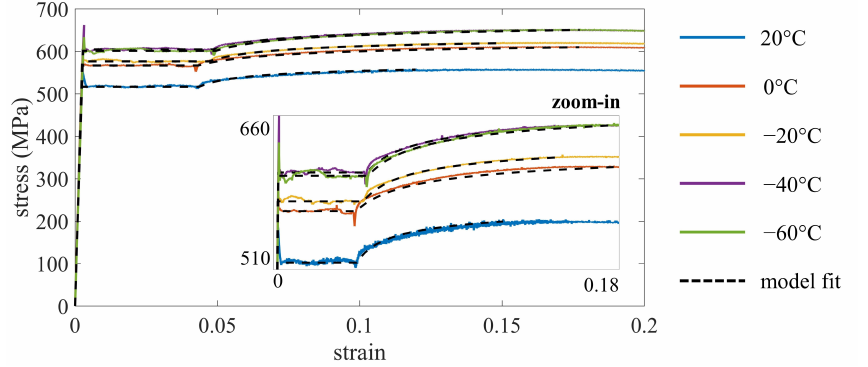
Figure 7. Experimental stress–strain curves from the steady-state subzero temperature tests with the fit between the test curves and the updated bilinear plus nonlinear model with recalibrated coefficients for Mild-395/450 at ambient and subzero